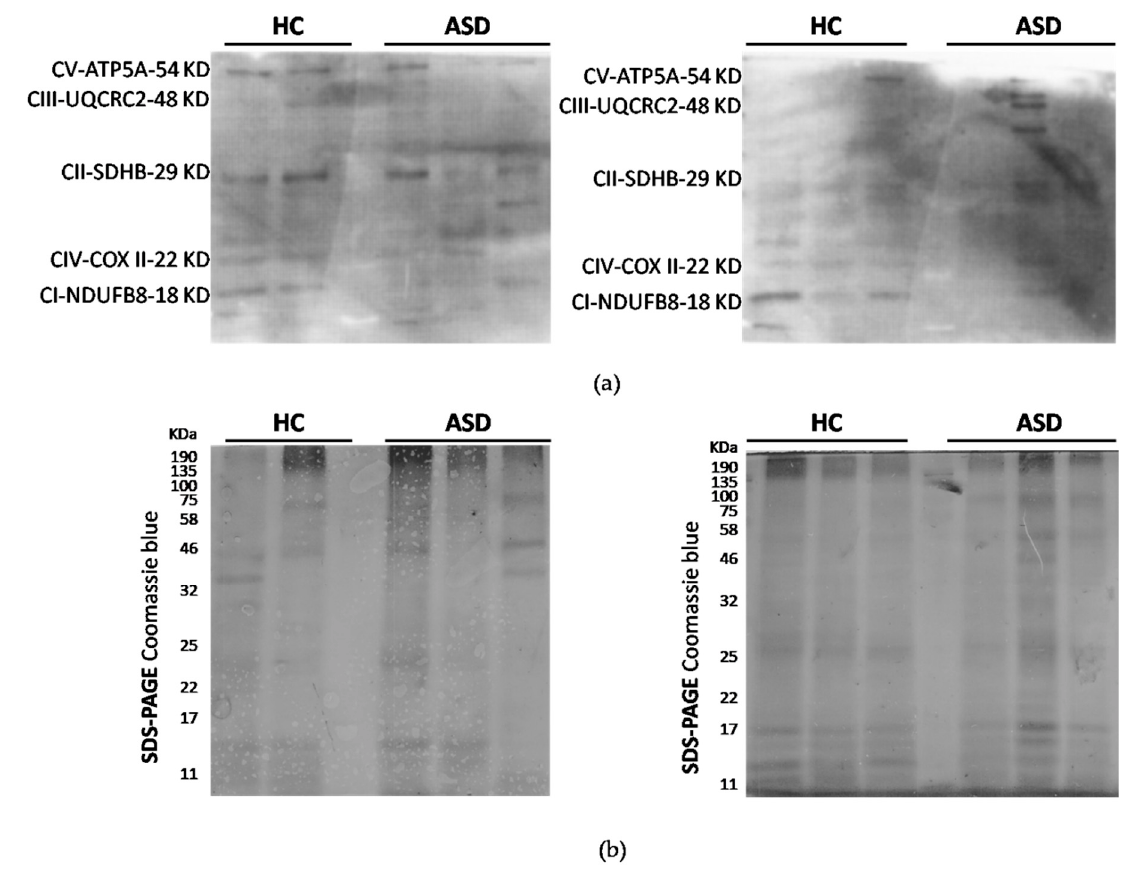
Figure 3. Protein expression analysis of mitochondrial respiratory complexes. ( a ) Oxidative Phosphorylation (OXPHOS) protein expression total proteins were obtained from oral mucosa and fractionated by SDS-PAGE. Complex I (CI), complex II (CII), complex III (CIII), complex IV (CIV) and ATP synthase (CV) were detected by immunoblots. ( b ) SDS-PAGE Coomassie blue staining was used as a loading control. n = 6 ASD and 5 HC children.